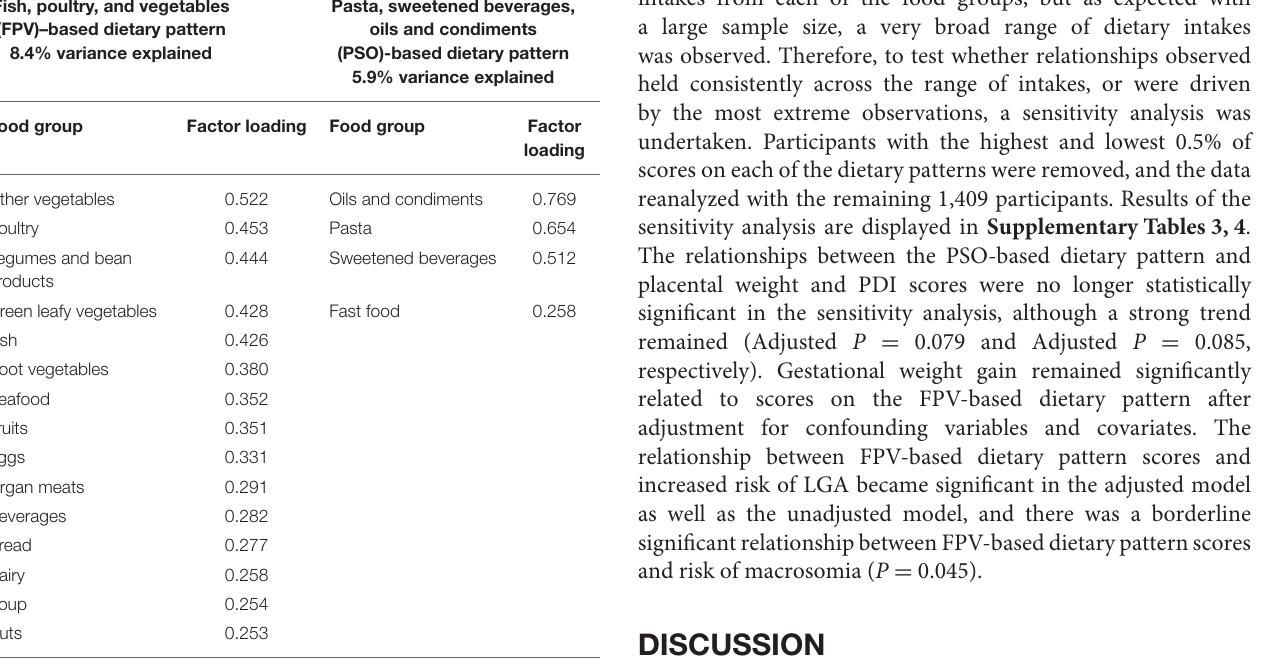
TABLE 2 | Key food components contributing to the two main dietary patterns consumed in the CLIMB cohort. Fish, poultry, and vegetables (FPV)–based dietary pattern